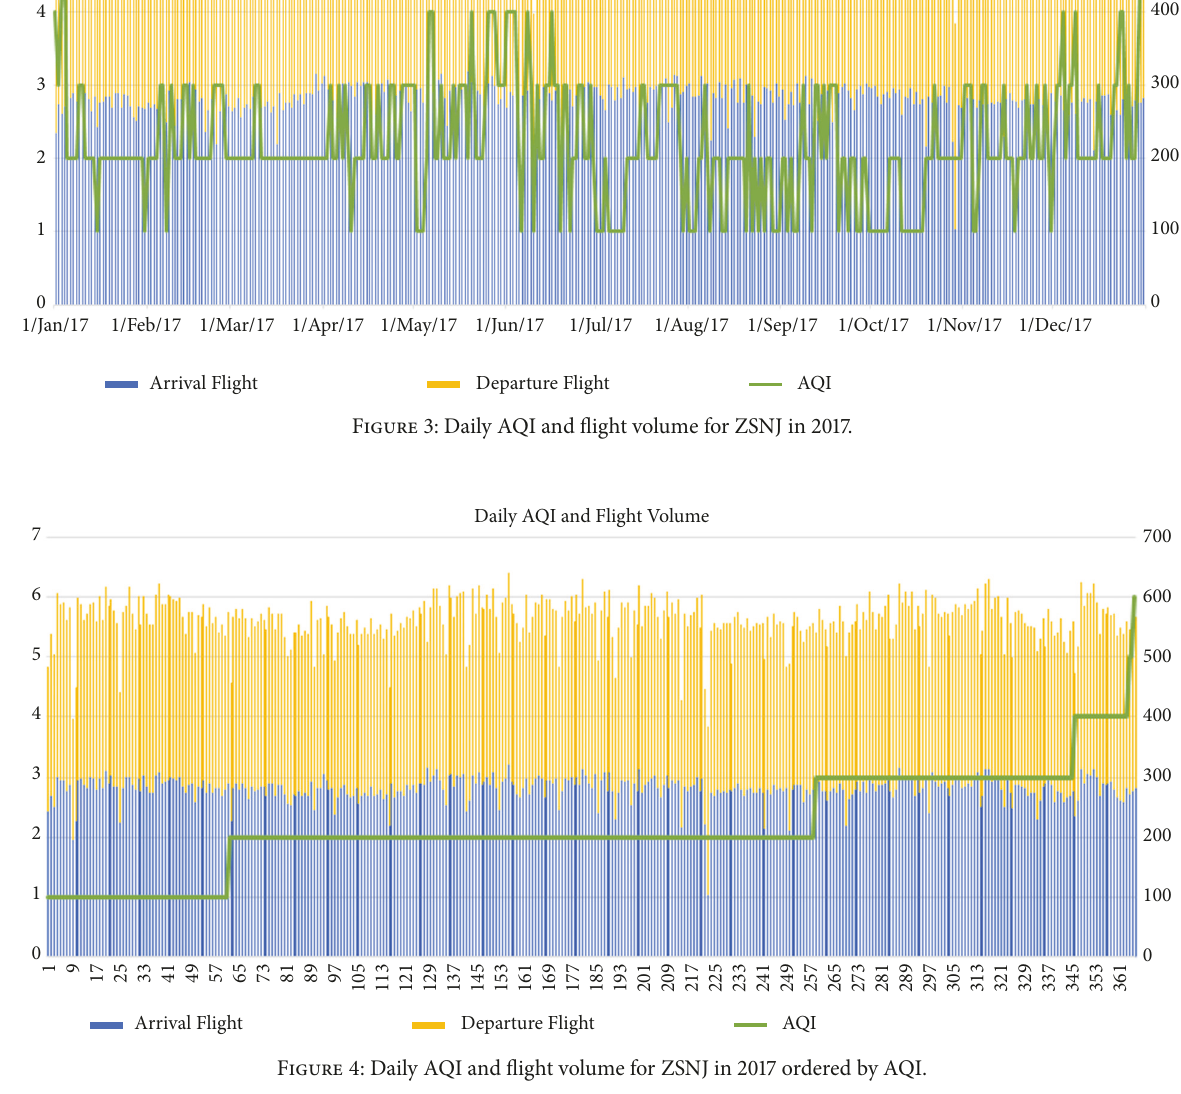
Figure 4: Daily AQI and flight volume for ZSNJ in 2017 ordered by